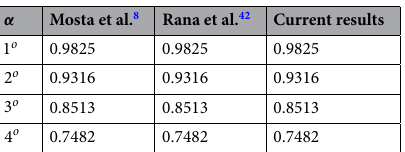
α Mosta et al. 8 Rana et al. 42 Current results 1